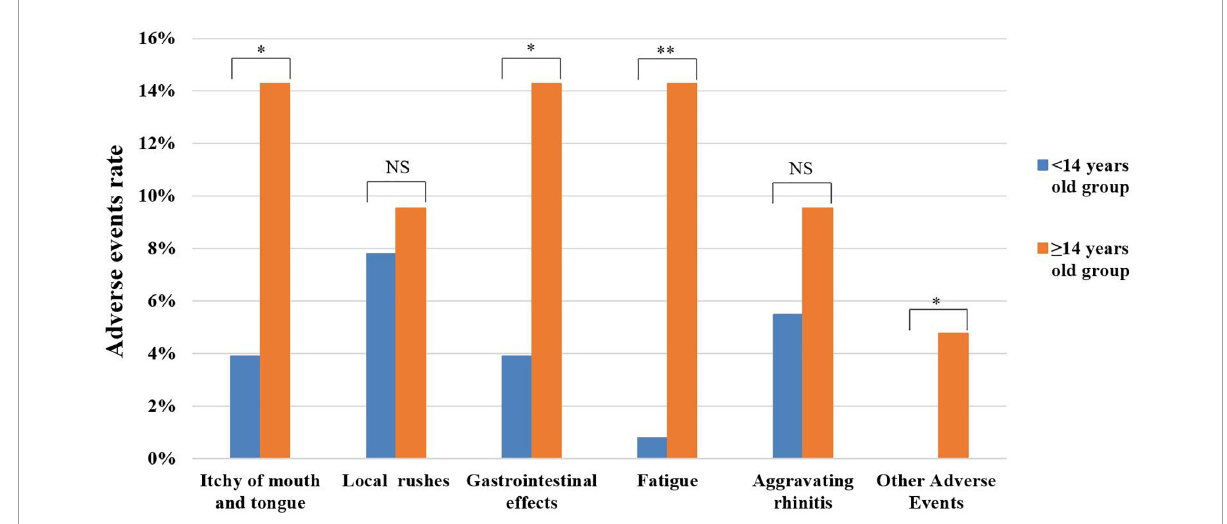
FIGURE3 Analysis of adverse events in different age groups during the first month. NS, no significance; ∗ P < 0.005; ∗∗ P < 0.001.